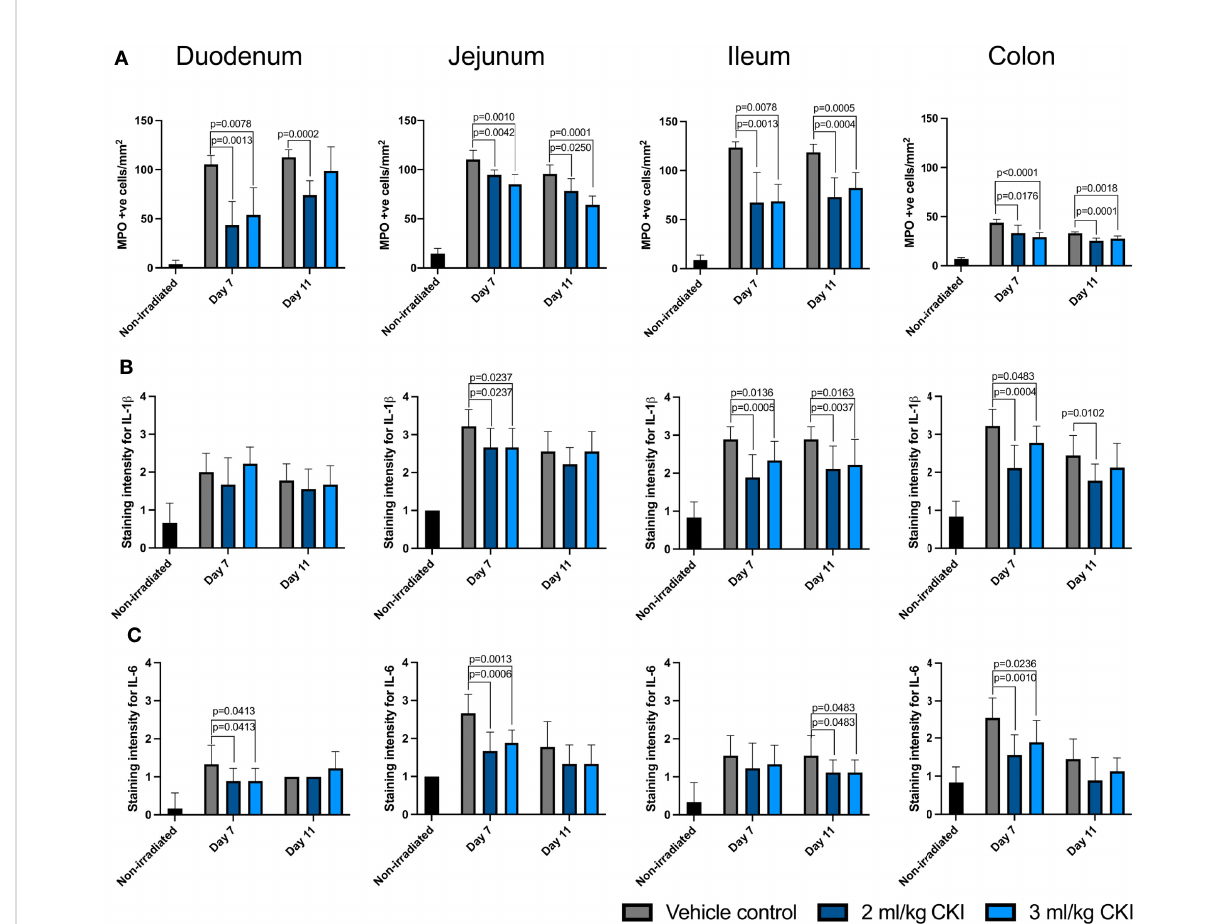
FIGURE 5 CKI administration reduces the levels of in fl ammatory factors in irradiated mucosa. (A) Number of MPO-positive cells in the irradiated intestine. (B, C) Levels of in fl ammatory cytokines IL-1 b (B) and IL-6 (C) in the irradiated intestine. The intestines were collected from irradiated rats with or without CKI treatment on day 7 and 11 post irradiation and paraf fi n-embedded tissues were sectioned for IHC detection of in fl ammatory factors. Data are presented as mean ±